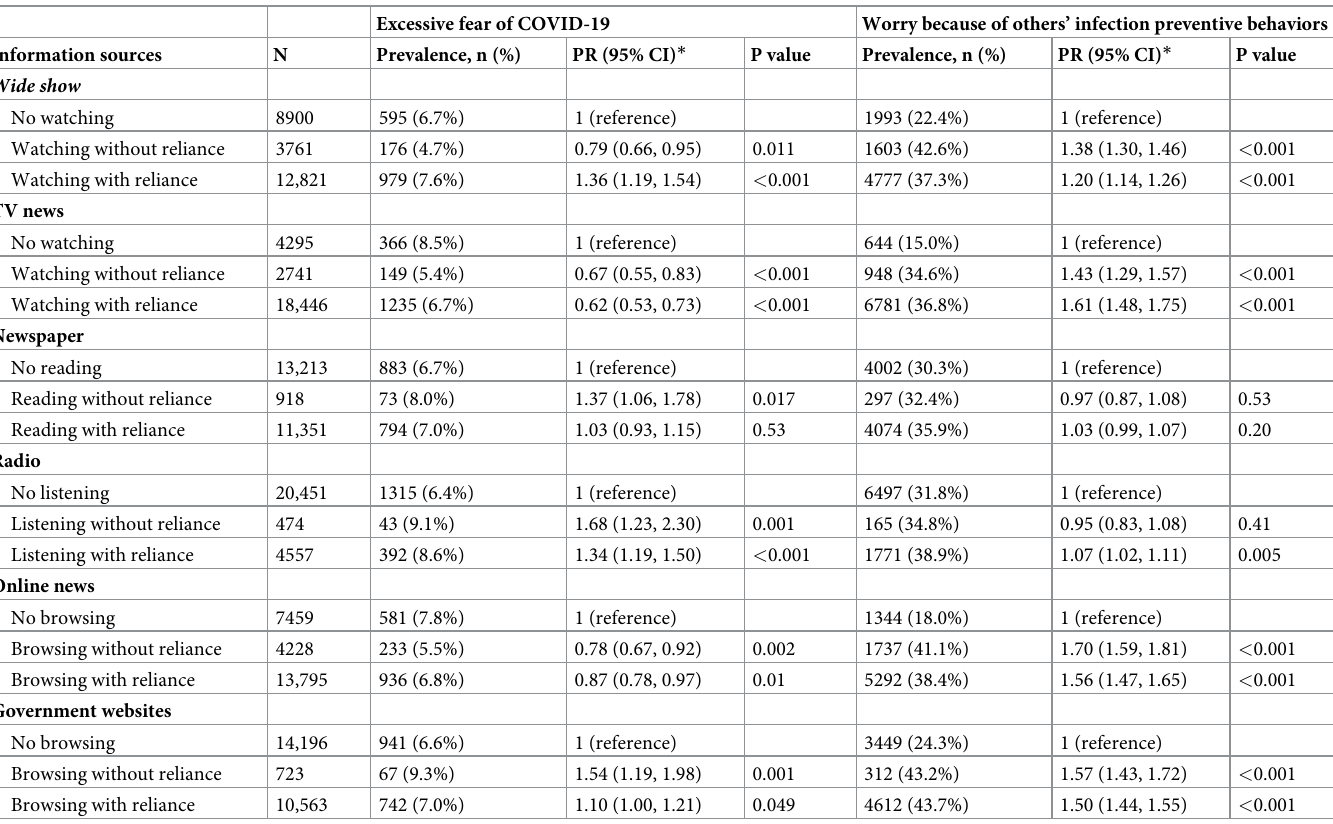
Table 3. Prevalence ratios of fear or worry because of others’ behaviors according to COVID-19 information